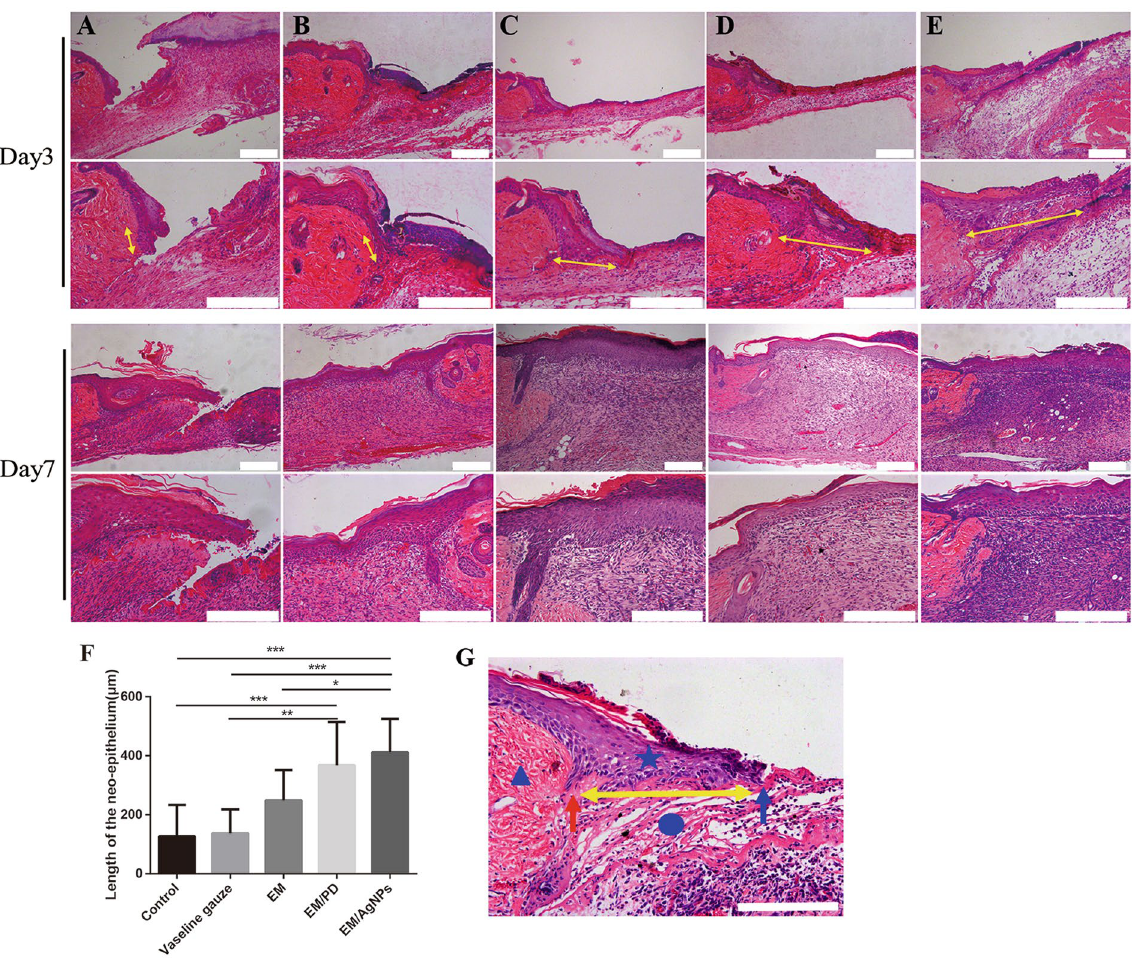
Figure 9. The effect of EM/AgNPs on re-epithelialization. Representative histological images (with H&E staining) of the length of the newly formed epidermis at days 3 and 7 post-surgery in the ( A ) control, ( B ) Vaseline gauze, ( C ) EM, ( D ) EM/PD and ( E ) EM/AgNPs groups. ( F ) Measurement of the length of the newly regenerated epidermis at day 3 post-surgery. ( G ) Schematic representation of the newly regenerated epidermis: the triangle represents the unwounded skin tissue, the circle represents the wound area, the pentagram represents the newly formed epidermis, the red arrow indicates border between unwounded skin tissue and wound area, the blue arrow indicates the advancing edge of newly-formed epidermis, and the yellow double- headed arrows indicate the length of the newly regenerated epidermis. The values are shown as the mean ± SD (n = 5). Scale bars: 200 μ